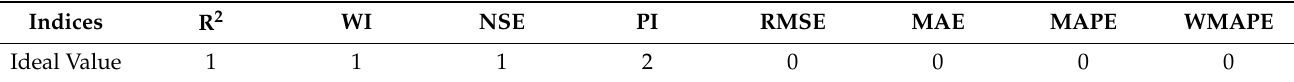
Table 4. The ideal values of different performance parameters.